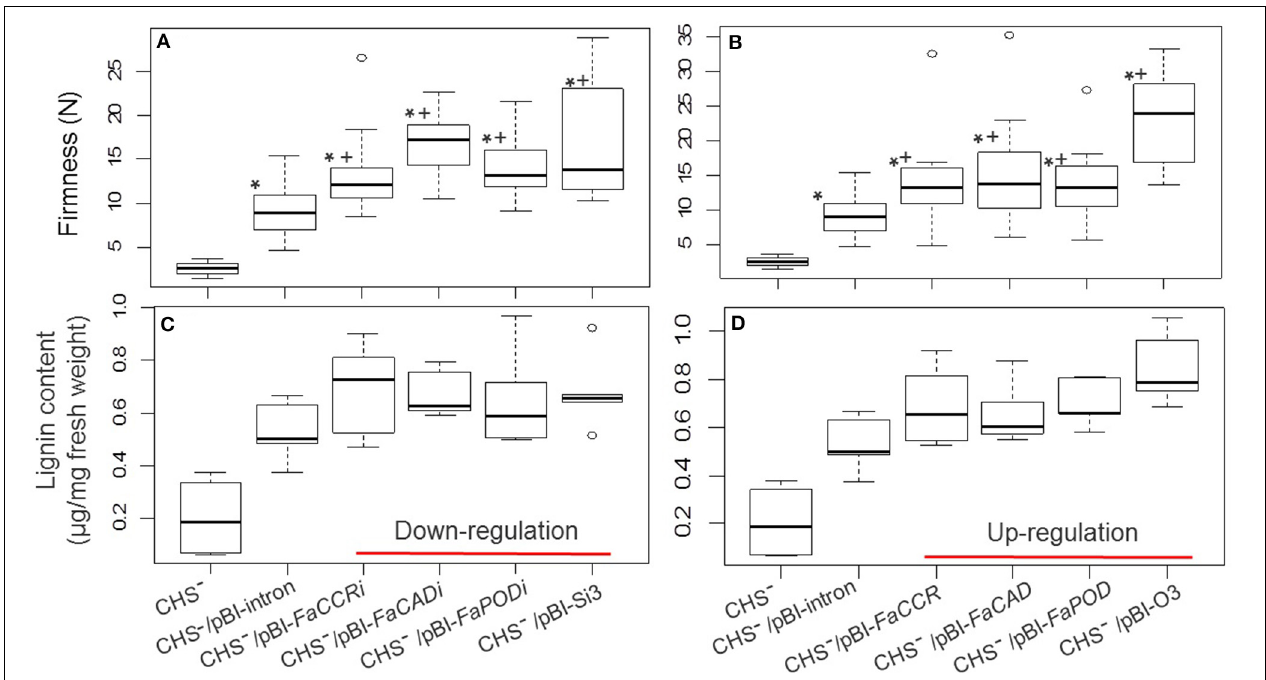
(CHS − /pBI- FaCCR ; n = 14, CHS − /pBI- FaCAD ; n = 17, CHS − /pBI- FaPOD ; n = 15), and combined three genes (CHS − /pBI-O3; n = 18). (C,D) Lignin content of each group ( n = 5). The Wilcoxon-Mann-Whitney U- test was used for non-parametric analysis of two groups. One asterisk ( ∗ ) or a plus ( + ) in the box marks statistically significant increased levels ( P < 0 . 05) in comparison with CHS − and another group (indicated by ∗ ), or in comparison with CHS − /pBI-intron and another group (indicated by +